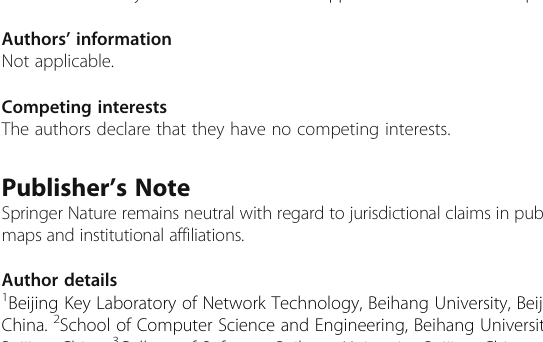
Acknowledgements Not